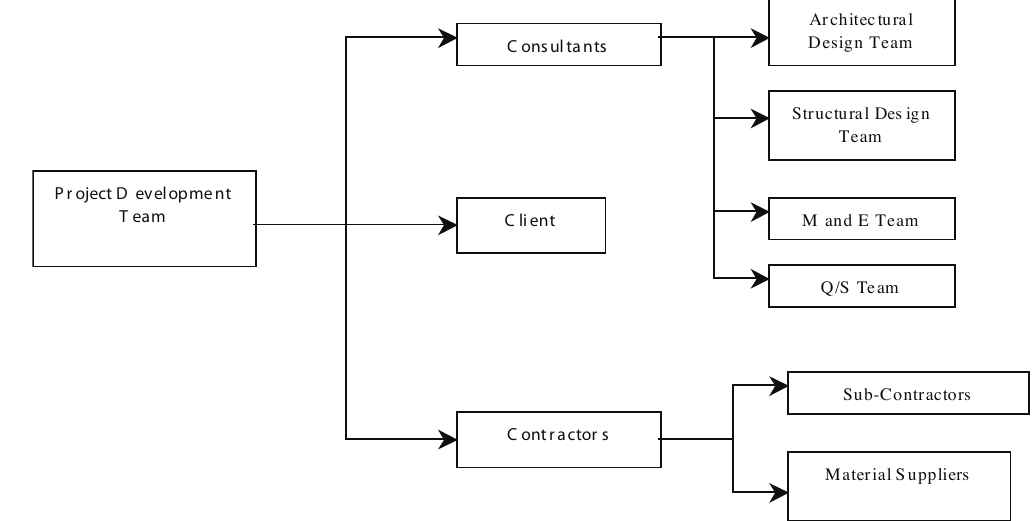
Figure 3: Typical team structure within a vonstruction organisation (Khalfan and Anumba,